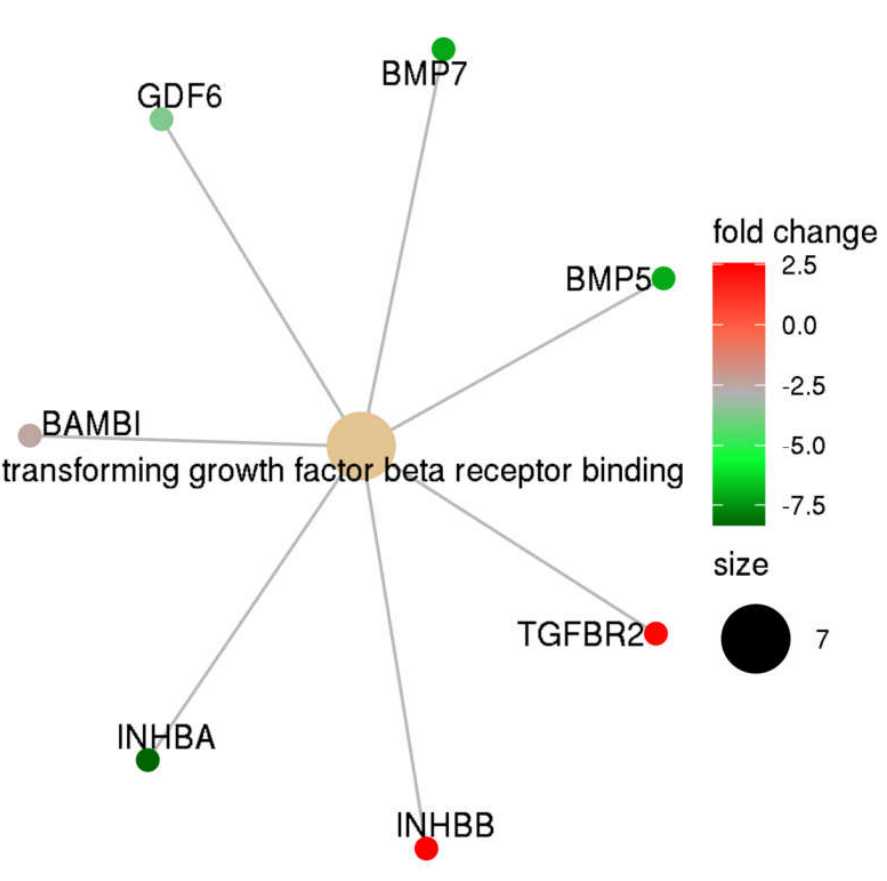
Figure 2. TGF- β family members’ expression profiles in postmolar choriocarcinoma when compared to that of complete hydatidiform moles.